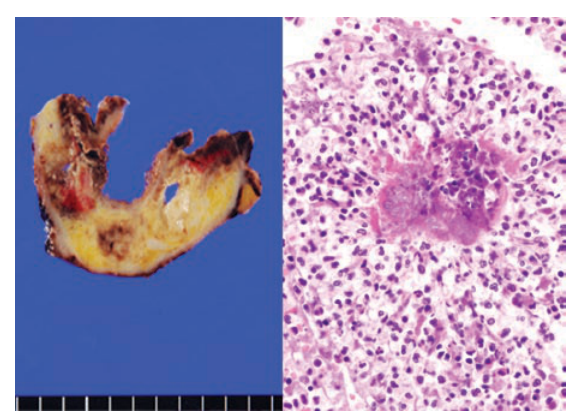
Figure 4. A cross-section of the gallbladder showed that gallbladder had a mass-like lesion that invaded the gallbladder wall. Histological examination revealed that a sulfur granule had branching filamentous bacilli and eosinophilic club- like projections that radiated from the periphery of the granule, compatible with Actinomyces (Hematoxylin and eosin stain,